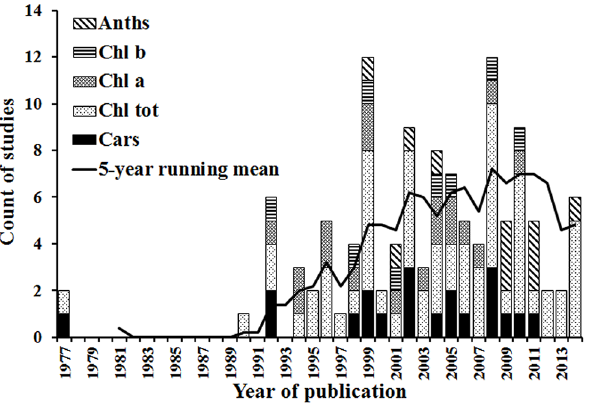
Fig 2. Histogram of numbers of selected studies published over time, showing the total in each year and the number focusing on each pigment type. The solid line is a 5-year running mean of the total number of